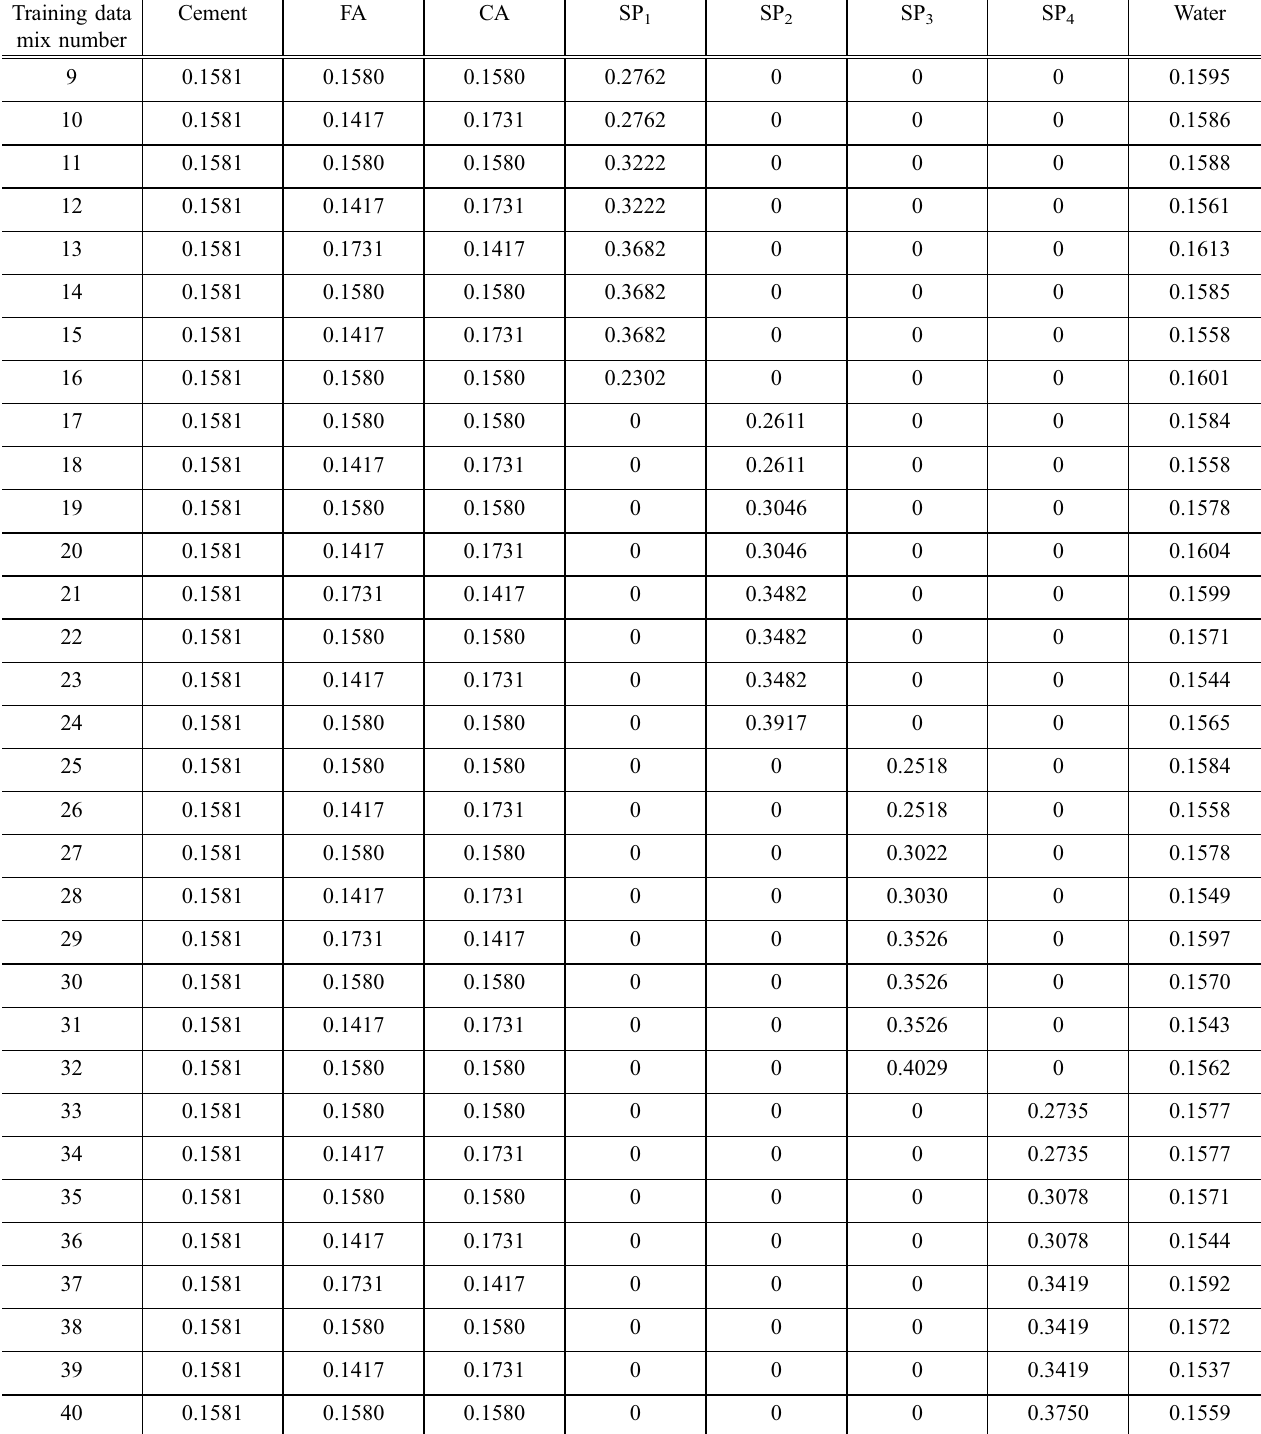
Table 4 Normalised input variables of SCC mixtures used to train the